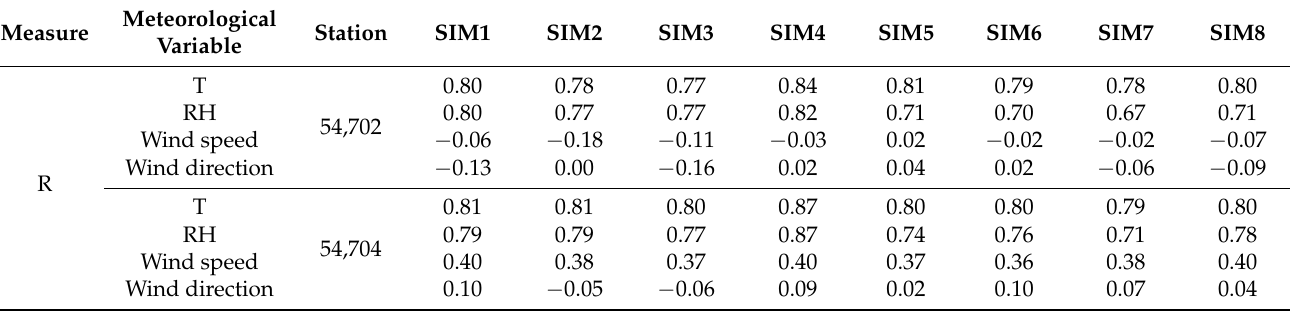
Table 6. The meteorological variable from observations and eight combined scheme simulations (Hengshui: 54,702, Jizhou: